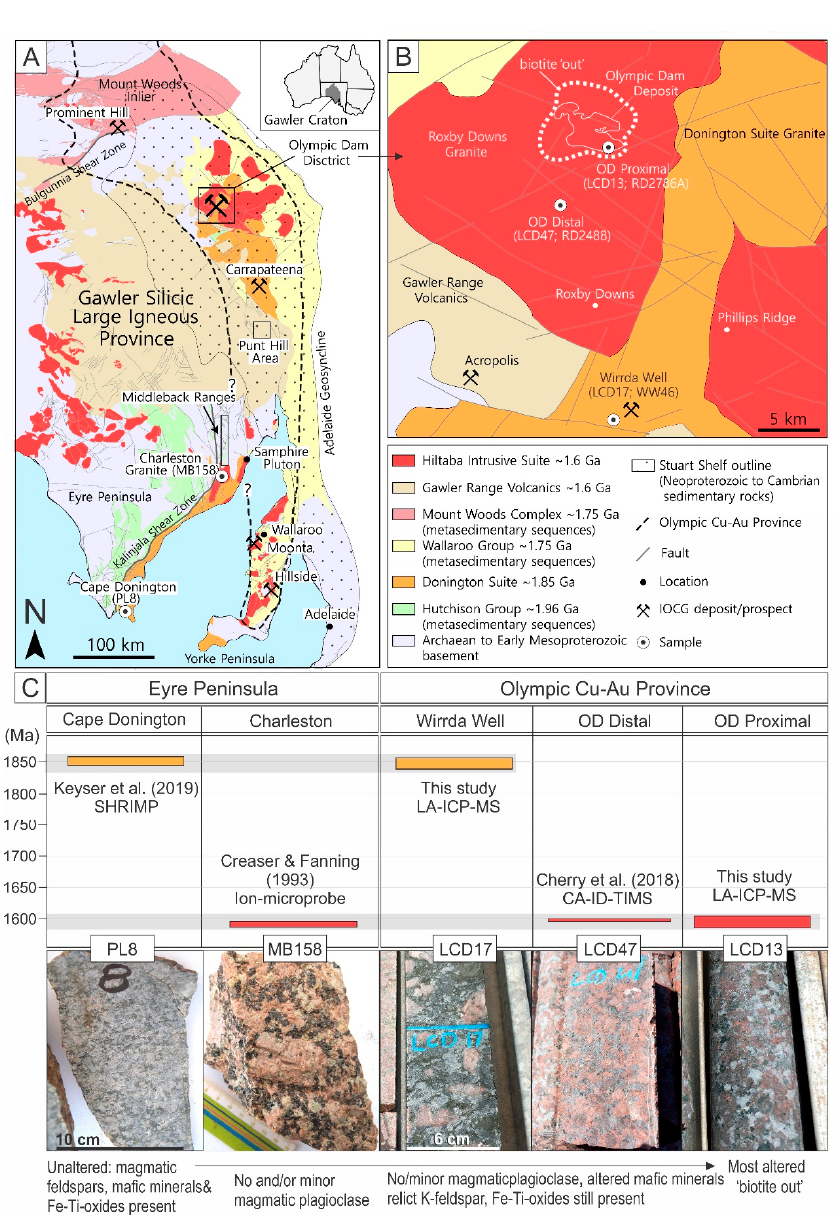
Figure 1. ( A ) Geological map of the eastern Gawler Craton and ( B ) the Olympic Dam district; data were taken from the Geological Survey of South Australia (https://map.sarig.sa.gov.au/). Locations of the five granite samples addressed in this study and the outline of the Olympic Cu–Au district are marked. ( C ) Table of ages and corresponding uncertainties (colored bars) for each granite sample studied here, with geochronology conducted either in this study (LA-ICP-MS) or in previous published work as indicated. The orange and red uncertainty bars represent the Donington Suite and Hiltaba Intrusive Suite, respectively, and their location within either the Eyre Peninsula or Olympic Cu–Au Province. Corresponding hand specimen photographs of each sample are shown below the age diagram, indicating degree of granite alteration. References: Keyser et al. (2019) [34]; Creaser and Fanning (1993) [36]; Cherry et al. (2018)